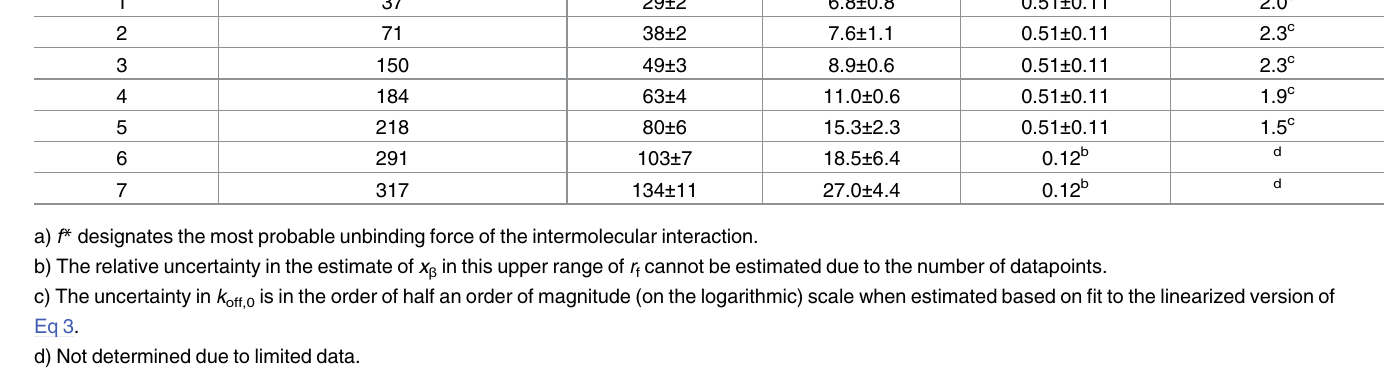
In order to investigate the potential Ca 2+ dependence of the interactions, OT experiments were performed prior to and after adding EDTA to the 100 mM Hepes buffer pH 7.2 contain- after adding EDTA (Fig 6A). The distribution of the rupture forces (Fig 6B) revealed a similar interaction strength as observed for the MUC1(Tn)–MGL interaction when investigated in the Hepes buffer prios to addition of EDTA (Fig 2E). Also in experimental series performed using 100 mM Hepes not containing Ca 2+ , force jumps were observed (Fig 6C).